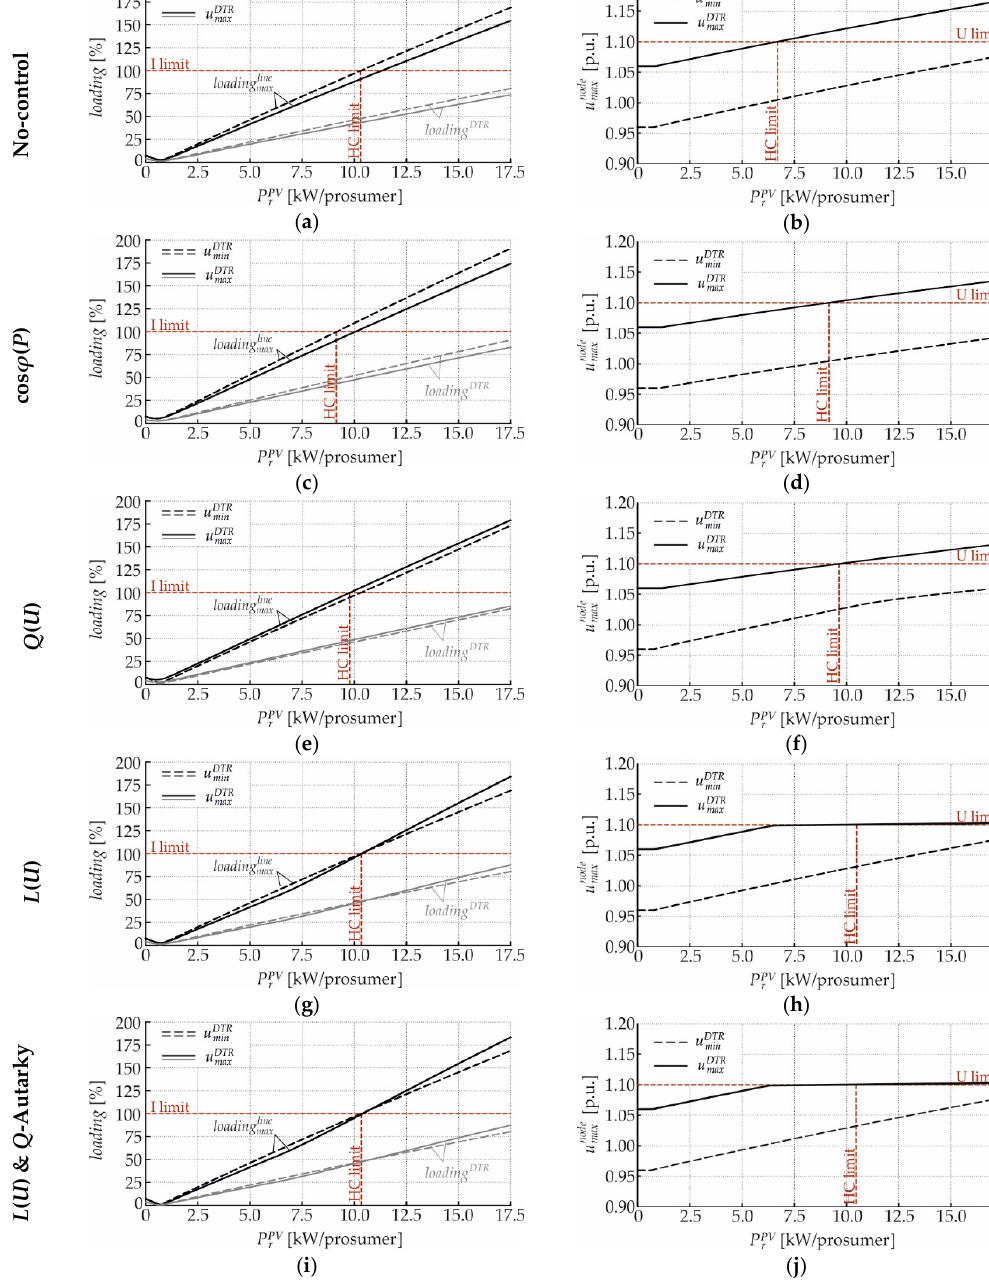
Figure 13. Current- and voltage-related hosting capacity limits of the short cable test-feeder for different control strategies: ( a , b ) no-control; ( c , d ) cos φ ( P )-control; ( e , f ) Q ( U )-control; ( g , h ) L ( U )- di ff erent control strategies: ( a , b ) no-control; ( c , d ) cos ϕ ( P )-control; ( e , f ) Q ( U )-control; ( g , h ) L ( U )-control; control; ( i , j ) L ( U )-control and Q -Autarkic prosumers. ( i , j ) L ( U )-control and Q -Autarkic